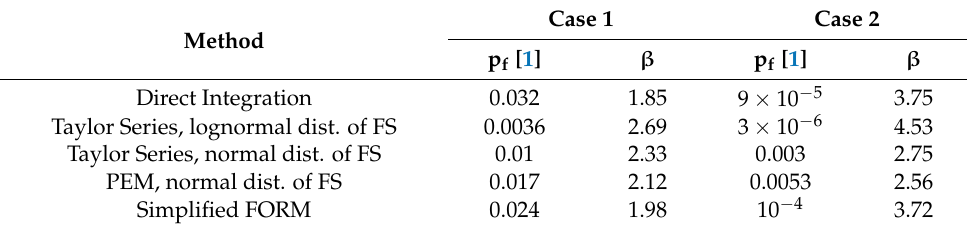
Table 1. Results of the reliability analyses of embankments stability for Cases 1 and 2 [1].